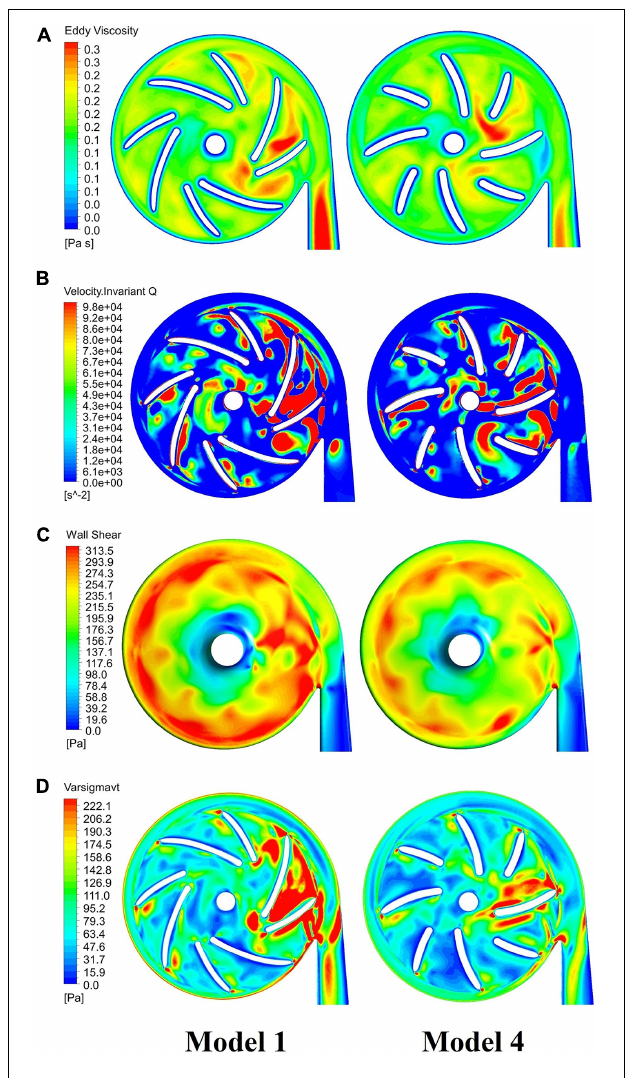
FIGURE 9 | Comparison of major indicators of flow field in blood pumps: baseline pump (model 1, left column) and optimized pump (model 4, right column), including: (A) eddy viscosity; (B) invariant Q of velocity; (C) wall shear stress at the casing; (D) effective stress.